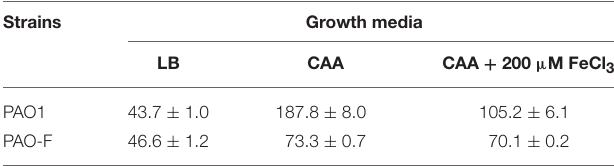
TABLE 1 | Doubling time for the P. aeruginosa PAO1 and PAO-F δ .